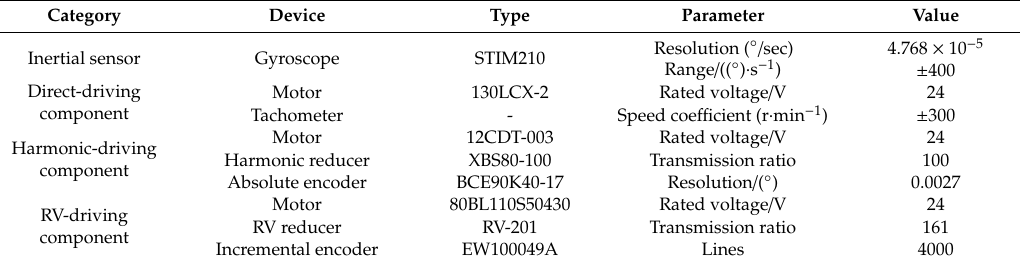
Table 2. System and controller parameters of the components.